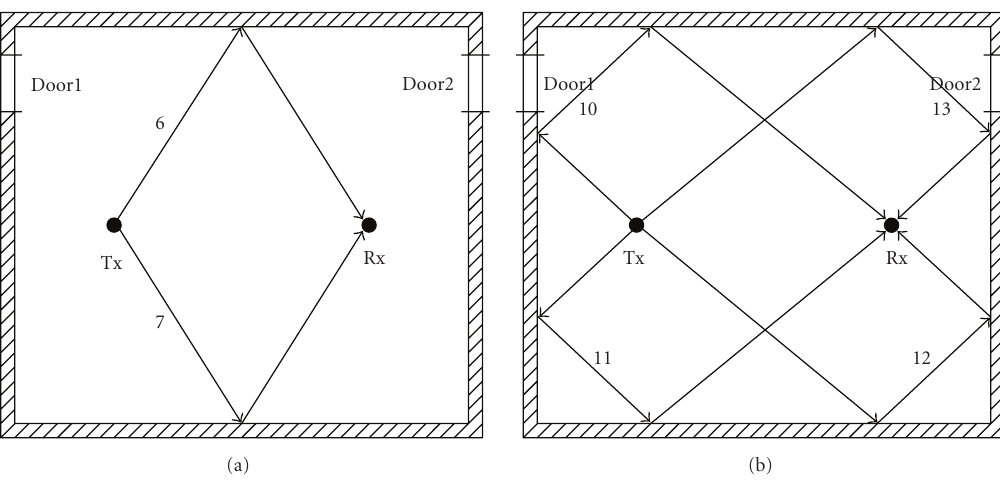
Figure 16: Illustration of paths (a) 6 and 7 (b) 10, 11, 12, and 13.